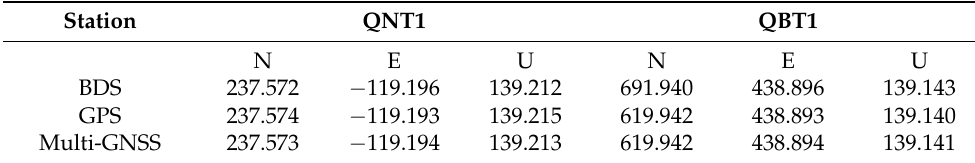
Table 9. Mean values of baseline resolutions